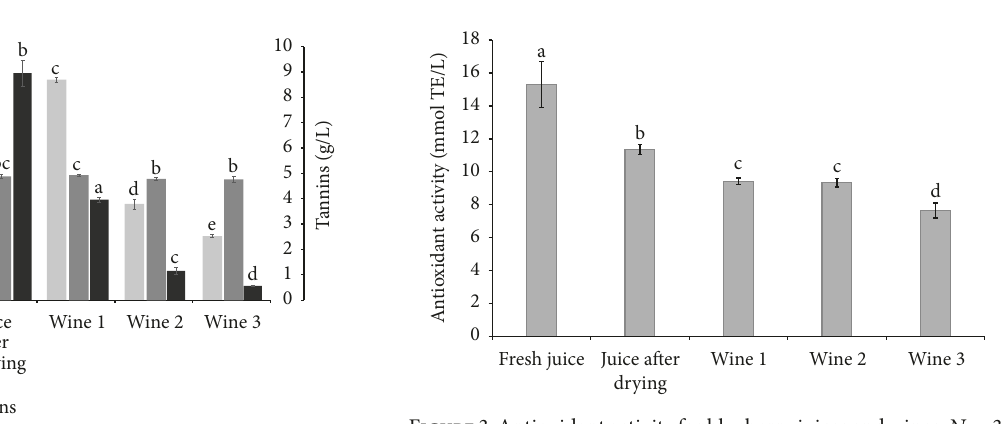
Figure3:Antioxidantactivityforblueberryjuicesandwines. 𝑁 = 3 . Columns with different superscript letters are significantly different, 𝑝 = 0.05